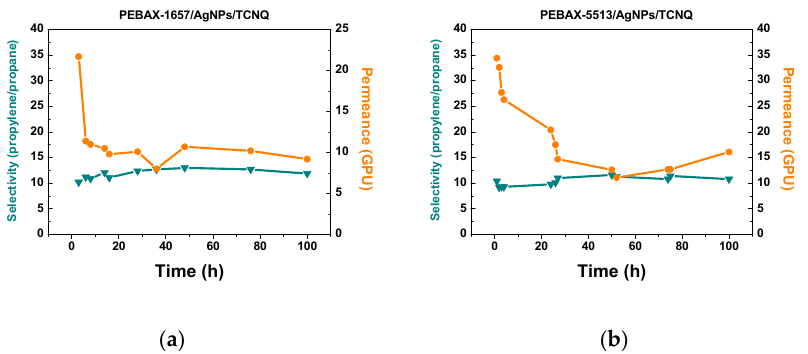
Figure 2. Long term gas separation performance of ( a ) PEBAX-1657/AgNPs/TCNQ and ( b ) PEBAX- 5513/AgNPs/TCNQ .